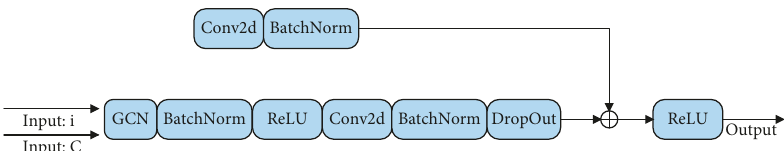
Figure 5: Spatiotemporal graph convolutional block.